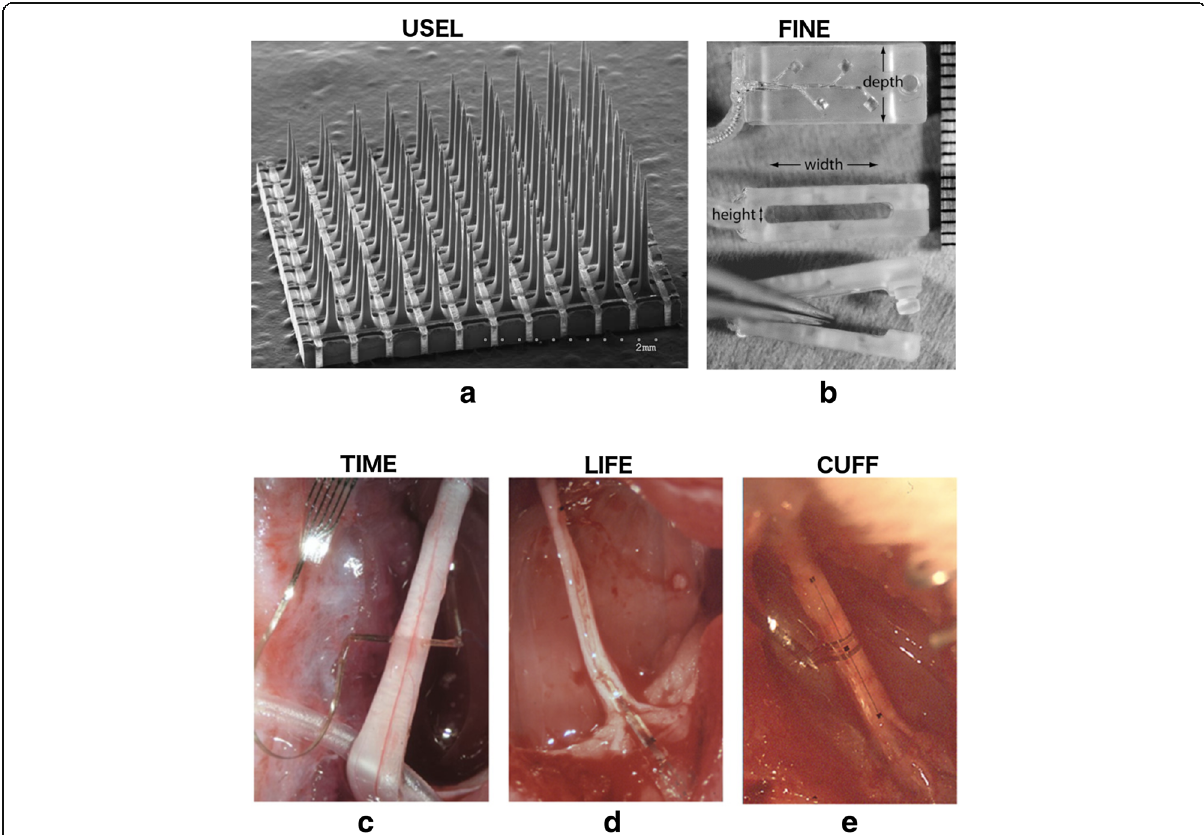
Fig. 2 Examples of various interfaces that have been used to access the peripheral nerves. a A silicon-based penetrating electrode array, the Utah Slanted Electrode Array, reproduced from (Branner et al. 2004), b – e polymer-based FINE, TIME, LIFE, and CUFF electrode arrays, reproduced from (Schiefer et al. 2010) and (Badia et al. 2011). The scale bar for b is on the right of the picture and is in mm. c – e are all implanted in the rat